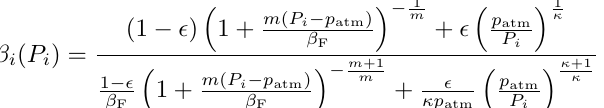
Figure 7: Simplified model structure for deriving lin- ear model of the system in motion operating